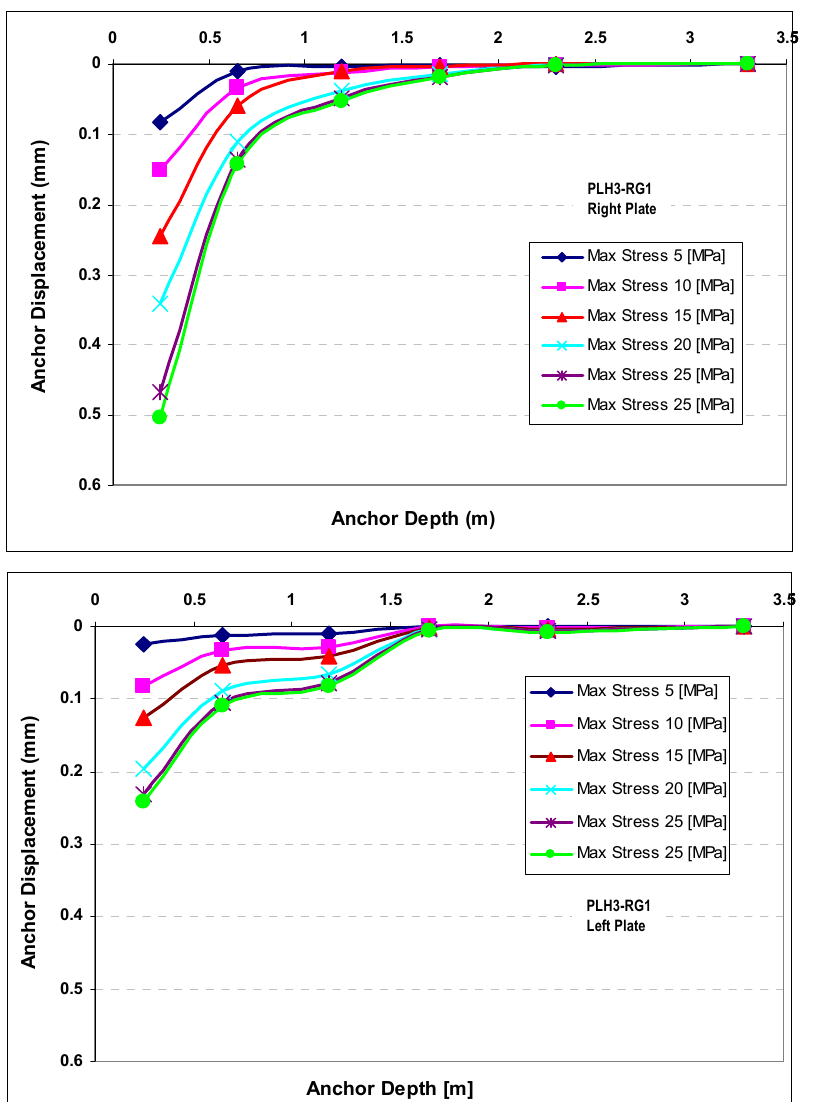
Figure 5. Rock displacement changes beneath the plates as a function of depth for all loading cycles [19].